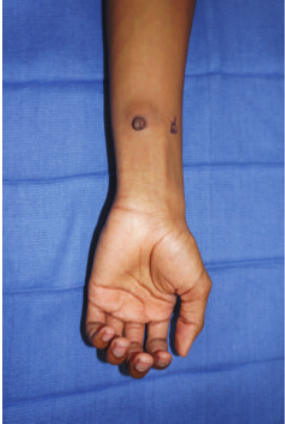
Figure 1: Volar view of forearm.